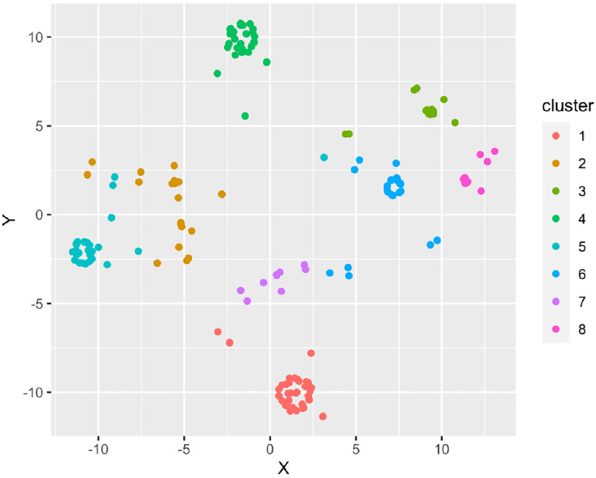
Figure 2. Viewing Gower clusters. Source: self-made by authors.